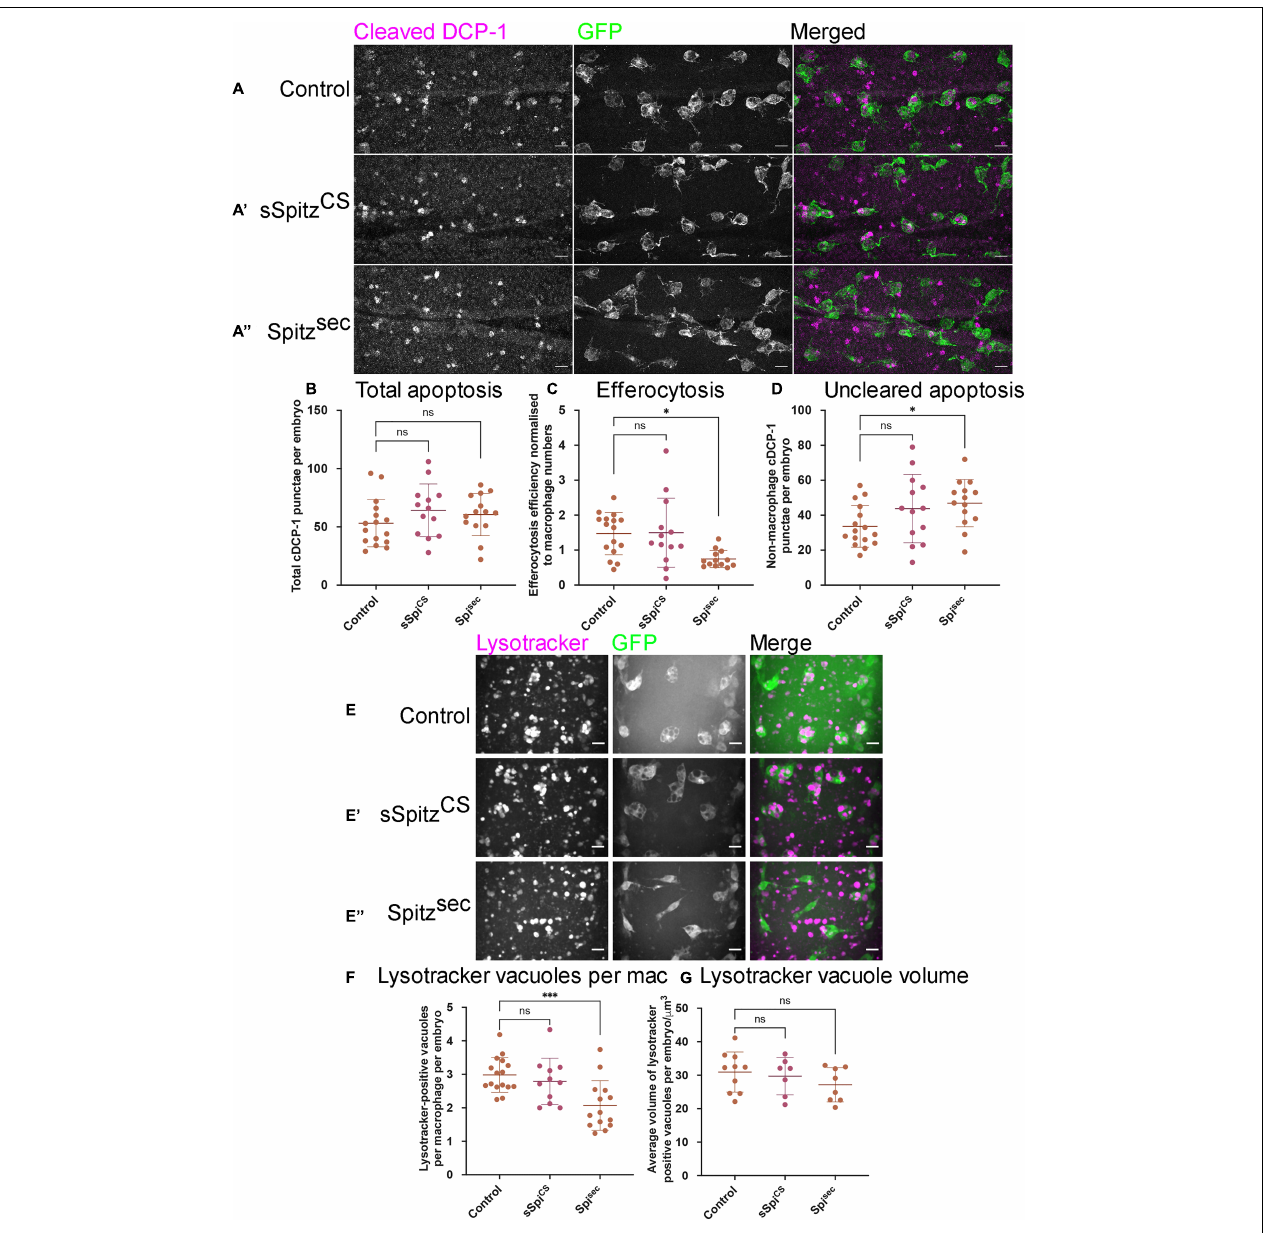
FIGURE 4 | Spitz impairs macrophage-mediated apoptotic cell clearance. (A) Maximum projections of the ventral region of stage 15 embryos immunostained for cleaved DCP-1 (cDCP-1; magenta in merge) and GFP (green in merge). Control embryos (A) were compared with embryos in which sSpitz CS (A (cid:48) ) or Spitz Se c (A (cid:48)(cid:48) ) were specifically expressed in macrophages. (B) Scattergraph showing the total numbers of cDCP-1 positive punctae present within the ventral field of view per embryo (B) ( n = 16, 13, 14; p = 0.265 and p = 0.519 for comparison of control vs. sSpi CS and control vs. Spi sec , respectively). (C) Scattergraph showing efficiency of apoptotic cell clearance/efferocytosis (percentage of cDCP-1 punctae engulfed by macrophages per field of view, per embryo, normalized according to numbers of macrophages in the field of view; n = 16, 13, 13; p = 0.994 and p = 0.0125 for comparison of control vs. sSpi CS and control vs. Spi sec , respectively). (D) Scattergraph showing average number of cDCP-1 punctae not engulfed by macrophages per field of view, per embryo ( n = 16, 13, 14; p = 0.142 and p = 0.0386 for comparison of control vs. sSpi CS and control vs. Spi sec , respectively). (E–E (cid:48)(cid:48) ) Images of macrophages (green in merge) with acidified phagosomes labeled using lysotracker red (magenta in merge) at stage 15 on the ventral midline in genotypes indicated. (F) Scattergraph showing numbers of lysotracker-positive punctae per macrophage, per embryo in the presence and absence of Spitz expression ( n = 16, 11, 14; p = 0.678 and p = 0.0009 for comparison of control vs. sSpi CS and control vs. Spi sec , respectively). (G) Scattergraph showing average volume of lysotracker-positive phagosomes per macrophage, per embryo in the presence and absence of Spitz expression ( n = 10, 7, 8; p = 0.873 and p = 0.284 for comparison of control vs. sSpi CS and control vs. Spi sec , respectively). Scale bars denote 10 µ m; lines and error bars represent mean and standard deviation on scattergraphs, respectively; significance bars denote ns p > 0.05, ∗ p < 0.05, and ∗∗∗ p < 0.001, respectively; all statistical comparisons made via one-way ANOVA with a Dunnett’s post-test. Embryo genotypes are as follows: w; Srp-GAL4,UAS-GFP/ + ; Crq-GAL4,UAS-GFP/ + (Control), w; Srp-GAL4,UAS-GFP/UAS-sSpitz CS ; Crq-GAL4,UAS-GFP/ + (sSpi CS ) and w;Srp-GAL4,UAS-GFP/ + ; Crq-GAL4,UAS-GFP/UAS-Spitz Sec (Spi sec ).